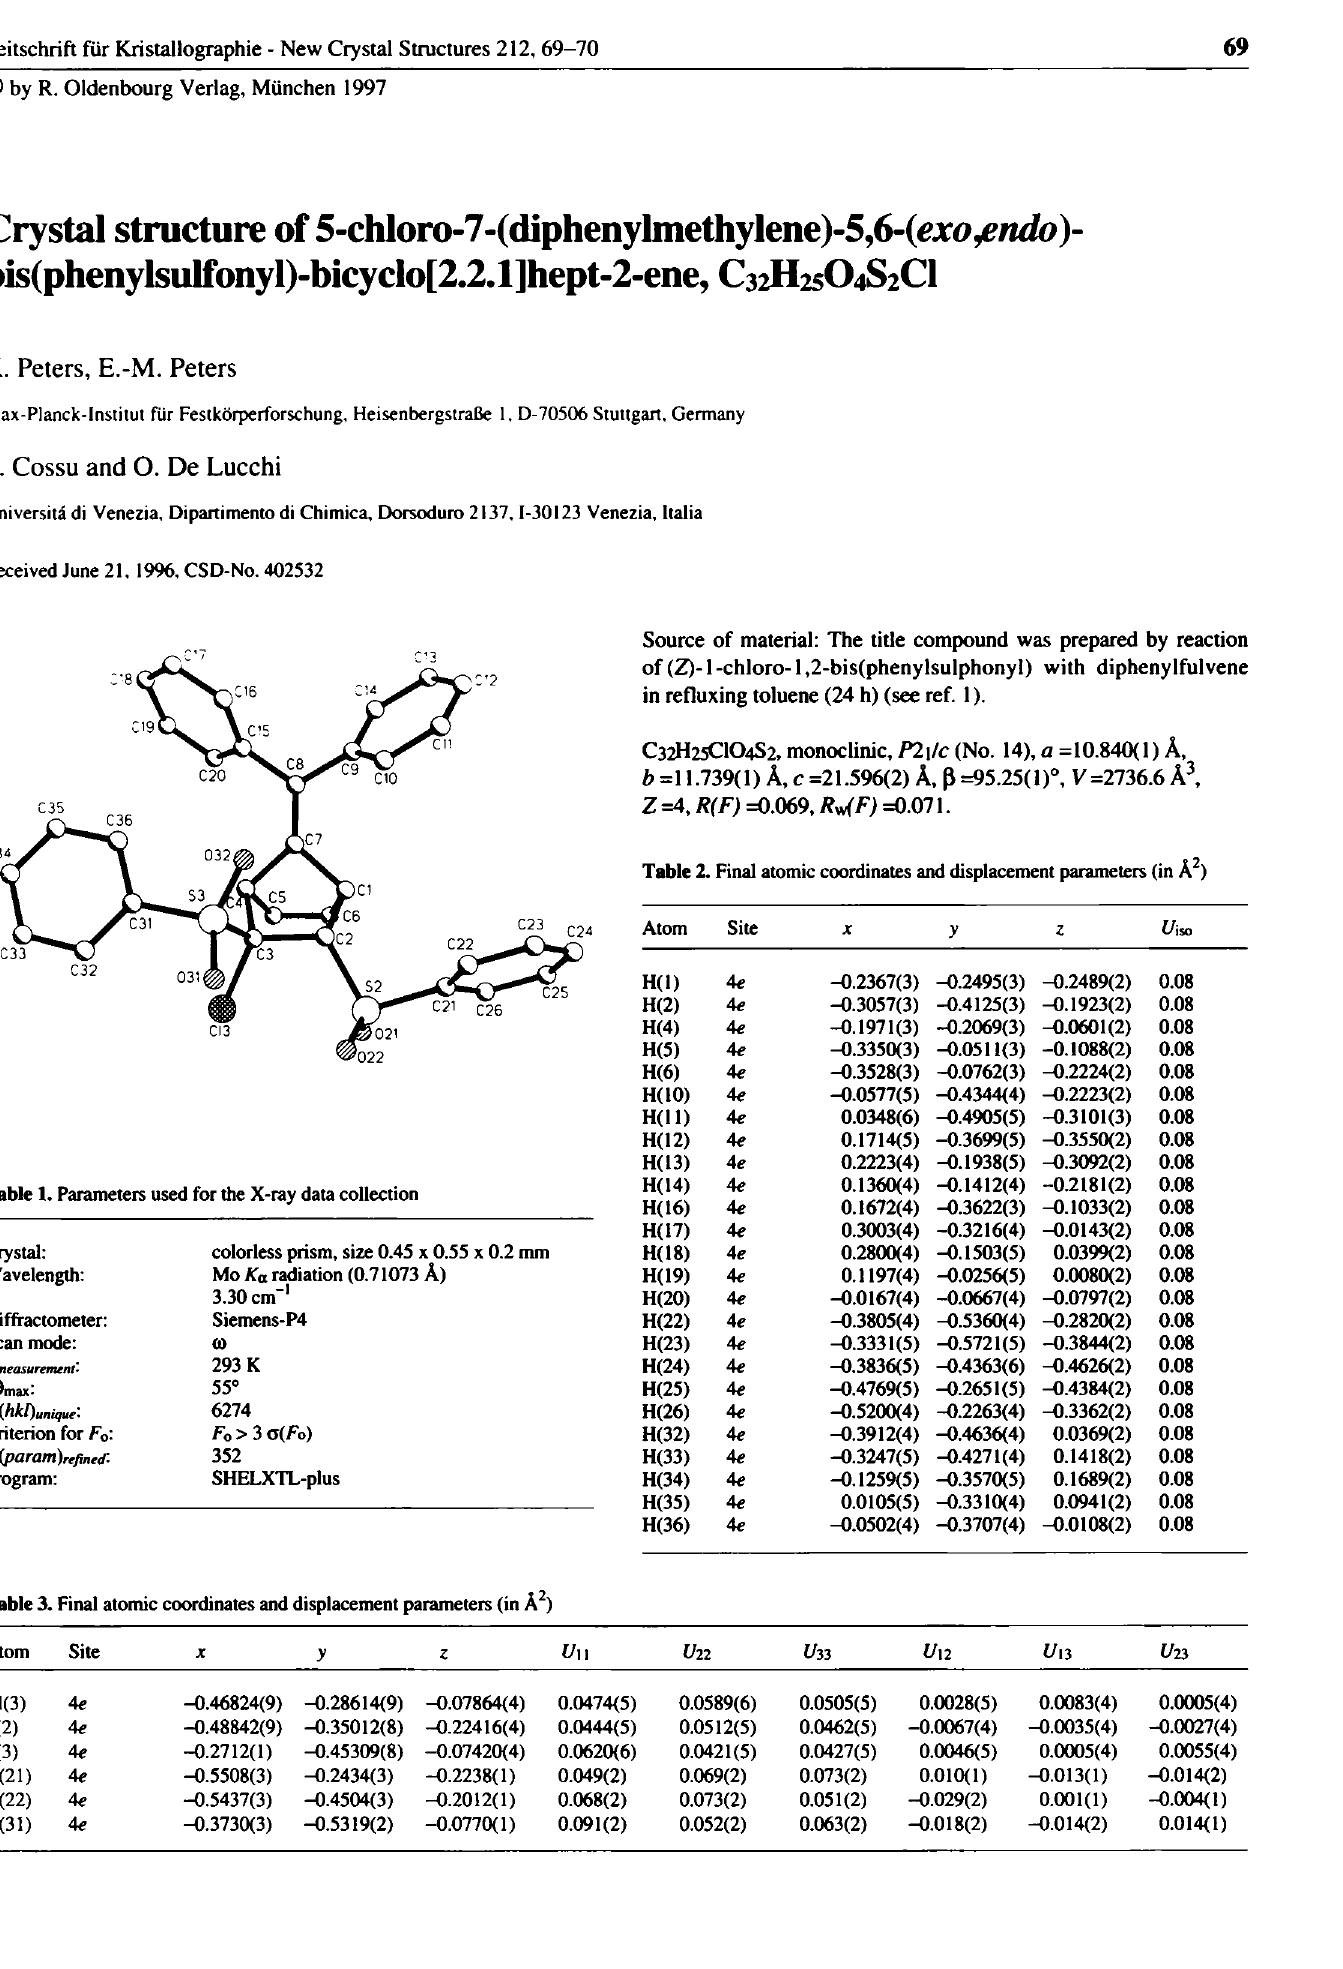
Table 3. Final atomic coordinates and displacement parameters (in Â 2 ) Atom